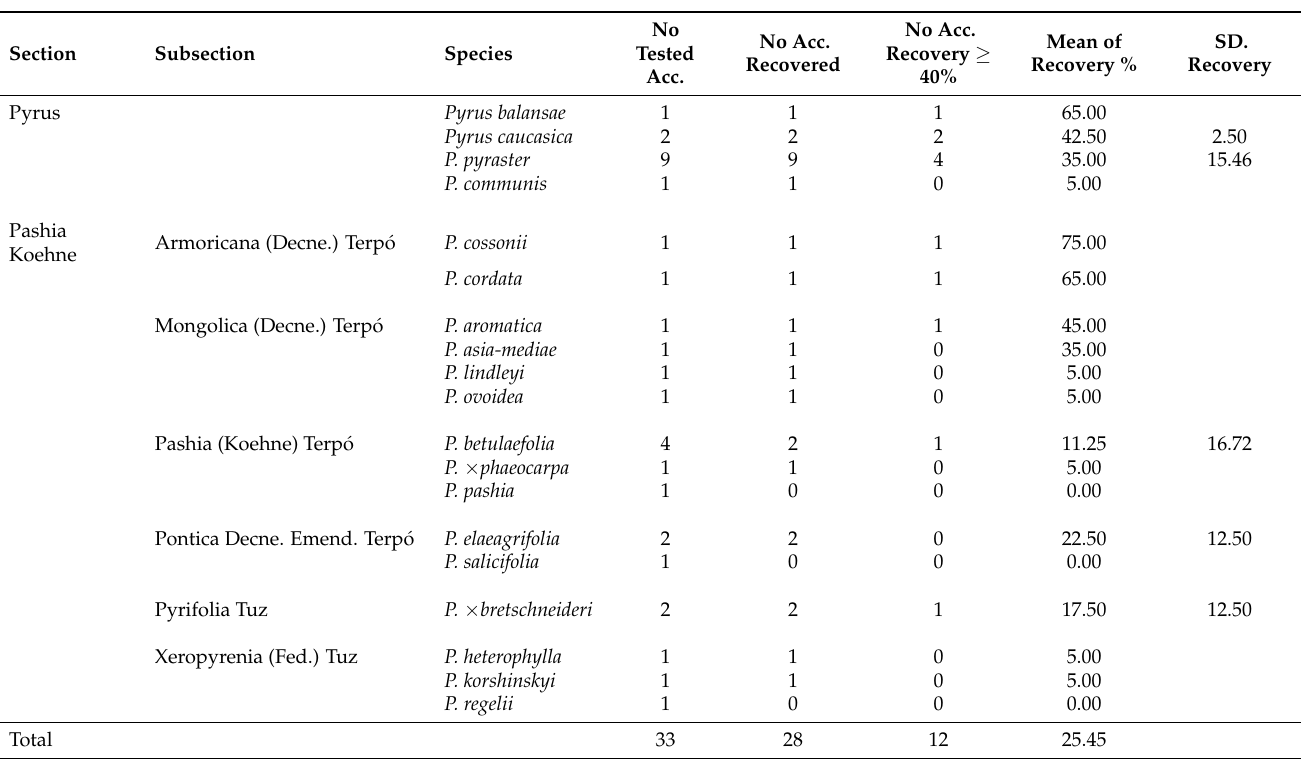
Table 2. Mean recovery rates after cryopreservation (%) of dormant bud explants is dependent on the Pyru s species. Seedling rootstock for chip budding was ‘Kirchensaller Mostbirne’. The taxonomic classification is according to Phipps et al.